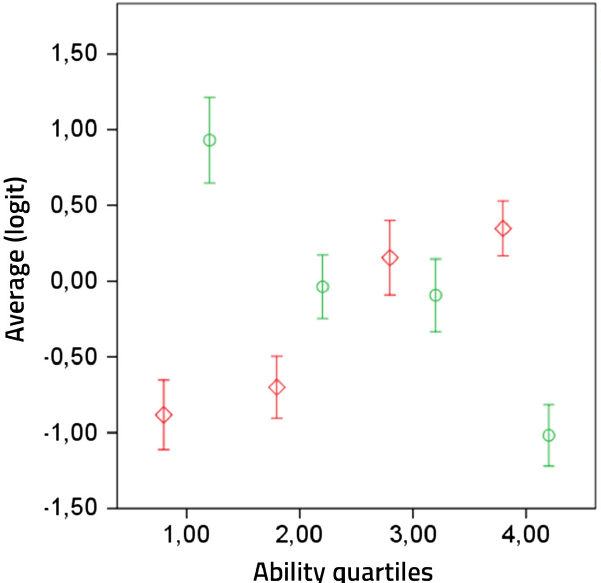
FIG. 7. Distribution of TLS and textbook groups subjects across confidence intervals of Table II.